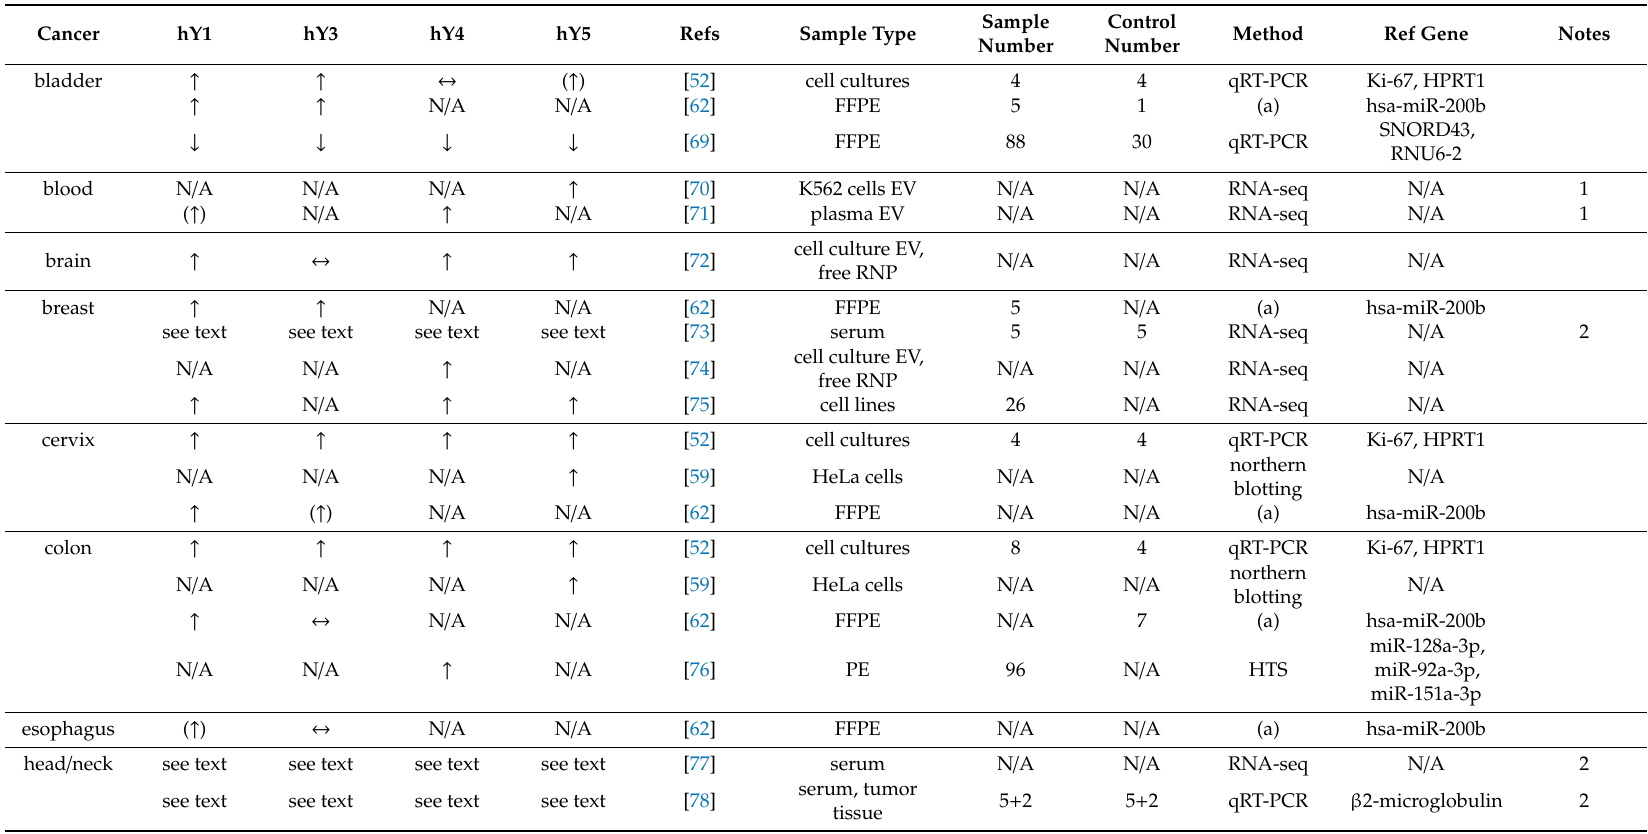
Table 2. Expression levels of Y RNA in various cancer types. Cancers are listed in alphabetical order according to the a ff ected organ, irrespective of their histology, for which we refer the reader to the main text; KS means Kaposi’s sarcoma, a multi-organ cancer. The word ‘serum’ is used for short to indicate blood serum. An arrow pointing upward means overexpression; an arrow pointing downward means under-expression; a horizontal, double-headed arrow indicates no significant change; arrows between parentheses indicate weak evidence. N / A means that no data are available. Refs indicates bibliographic references, while ref gene indicates the gene(s) used for quantitative comparison. See the text for further